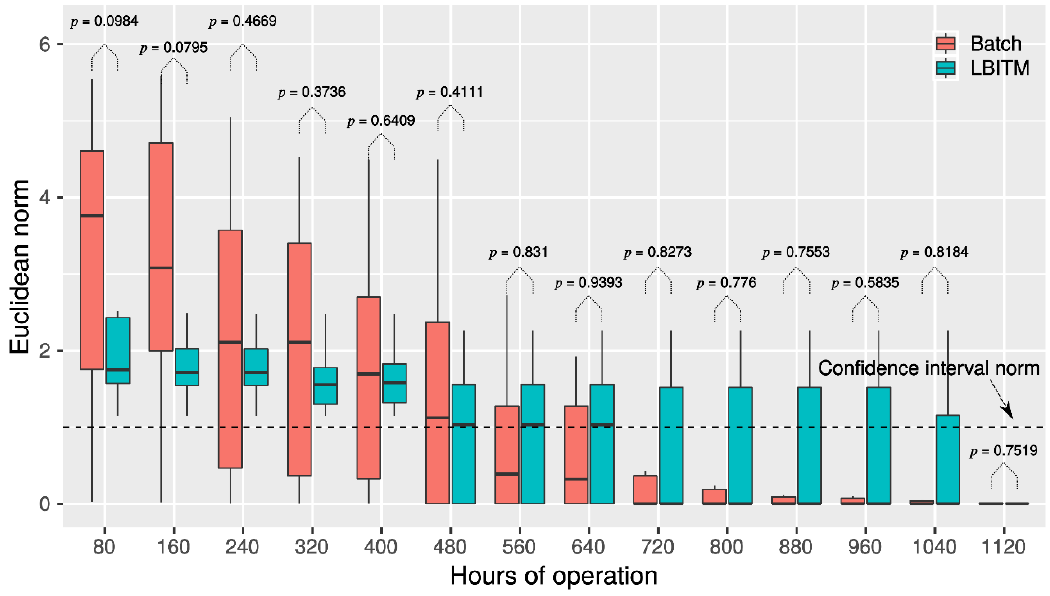
Figure 3. The evolution of the estimation steps for the batch estimation and the live Bayesian inference of transition matrices (LBITM) for building B. The graph was normalised considering the estimation error equal to 1. The error considered the Euclidean distance between the matrices. Building A was also used, in this case, to obtain an informed prior for a transition matrix that represented the temperature switching of the thermostat.